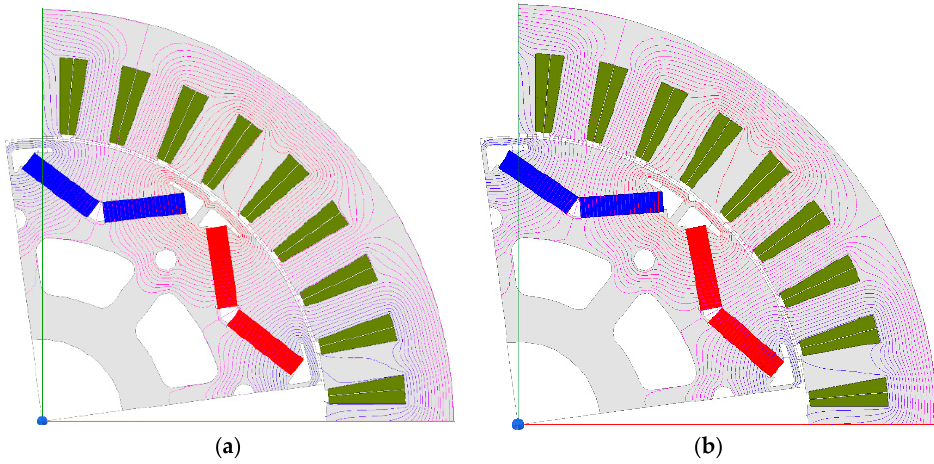
Figure 10. Flux distribution under the no load condition: ( a ) initial model; ( b ) optimal model.